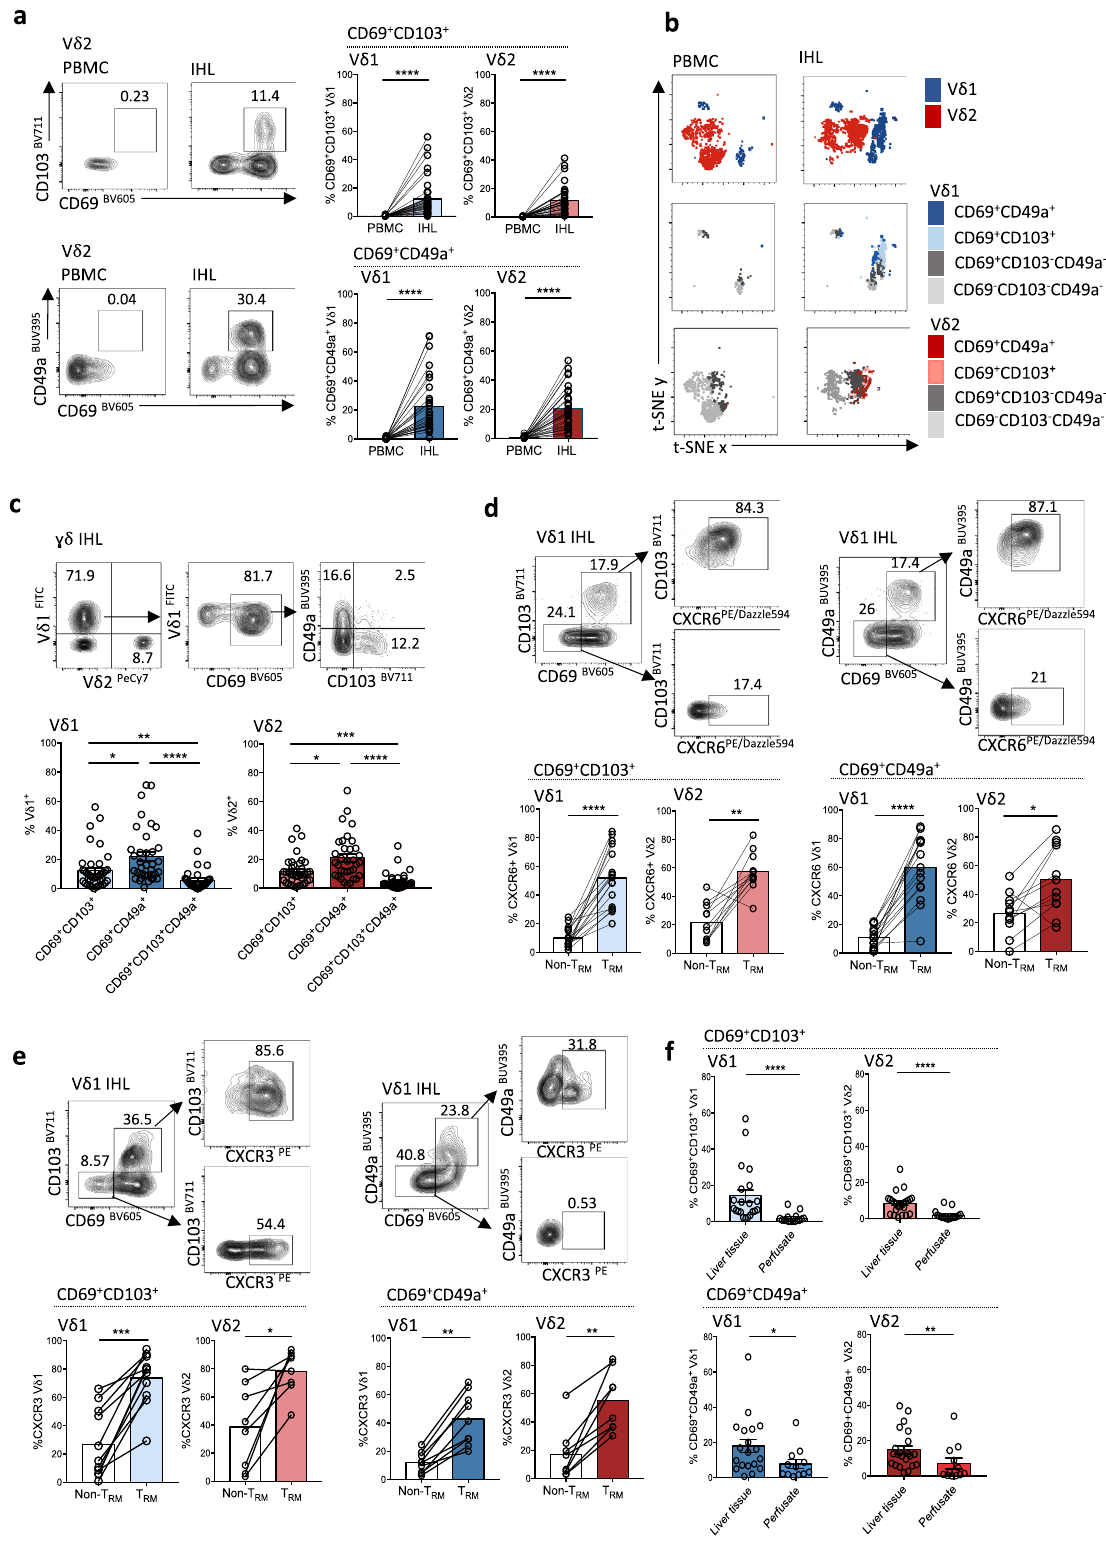
Fig. 1d, e). Ligands for these chemokine receptors are expressed by hepatic sinusoidal endothelium, promoting homing, tethering and/or transmigration into the parenchyma 43,44 . Consistent